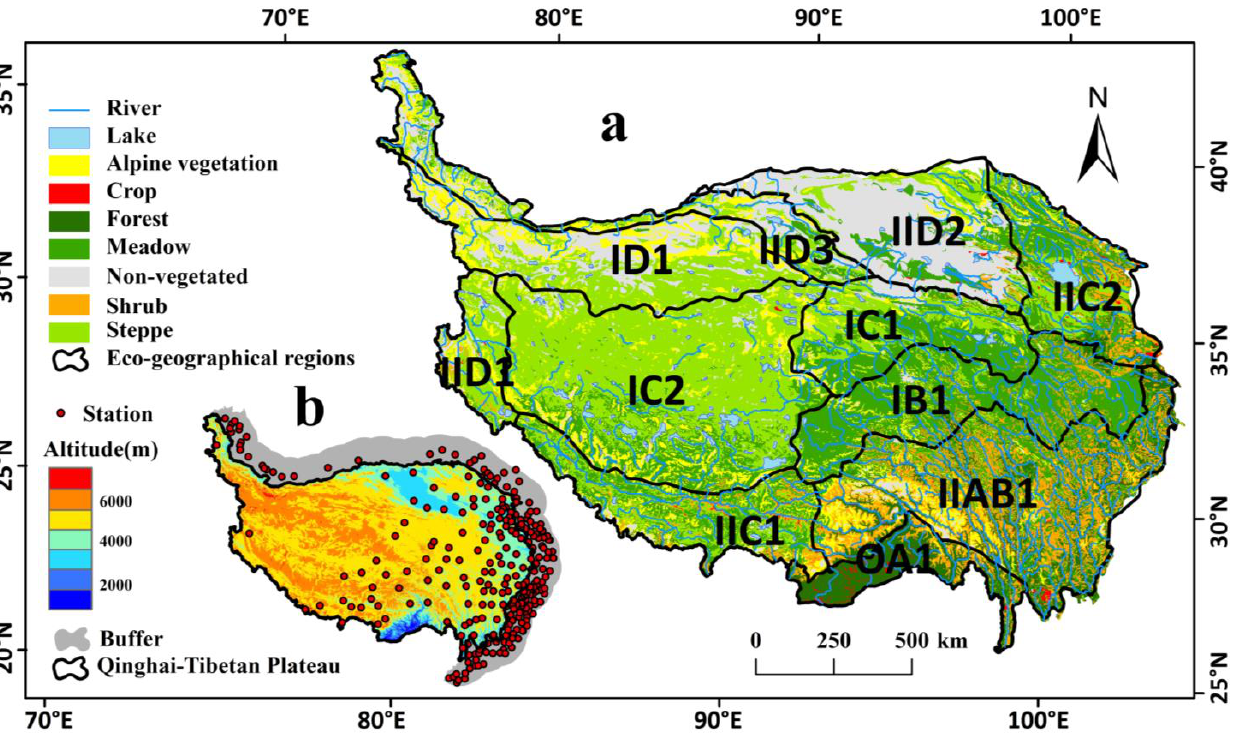
Figure 1. Spatial distribution of vegetation types ( a ) and meteorological stations ( b ) on the Qinghai- Tibetan Plateau (QTP).